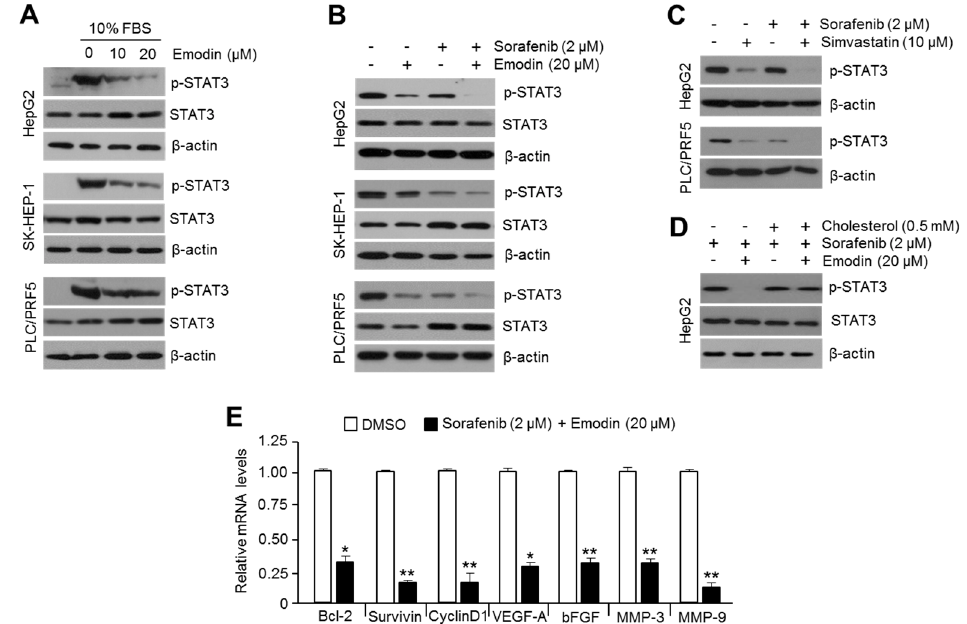
Figure 7. The combination treatment of emodin and sorafenib synergistically suppressed STAT3 and the associated expression of cell cycle-regulating target genes. ( A ) Emodin inhibits the phosphorylation of STAT3. Three HCC cell lines were incubated with emodin (10 and 20 μ M) for 24 h. ( B ) The synergistic effect of the emodin and sorafenib combination on STAT3 phosphorylation. The cells were incubated with 20 μ M of emodin, 2 μ M of sorafenib, or their combination (20 μ M emodin and 2 μ M sorafenib) for 24 h. ( C ) Simvastatin increased the suppressive effect of sorafenib on STAT3 phosphorylation. HepG2 and PLC/PRF5 cells were incubated with 2 μ M of sorafenib, 10 μ M of simvastatin, or the combination of sorafenib and simvastatin, as indicated, for 24 h. ( D ) The supplementation of cholesterol blocked the downregulation of STAT3 phosphorylation after the combination treatment of emodin and sorafenib. HepG2 cells were treated with water-soluble cholesterol (0.5 mM) for 1 h prior to the combination treatment of emodin and sorafenib, and the cells were incubated for a further 24 h. Protein expression was measured by Western blotting. ( E ) The combination of emodin and sorafenib decreased the expression of cell cycle-promoting STAT3 target genes. HepG2 cells were incubated for 24 h with the combination (20 μ M emodin and 2 μ M sorafenib). The values represent the mean ± SD of three independent experiments performed in duplicate; * p < 0.05 and ** p < 0.01.